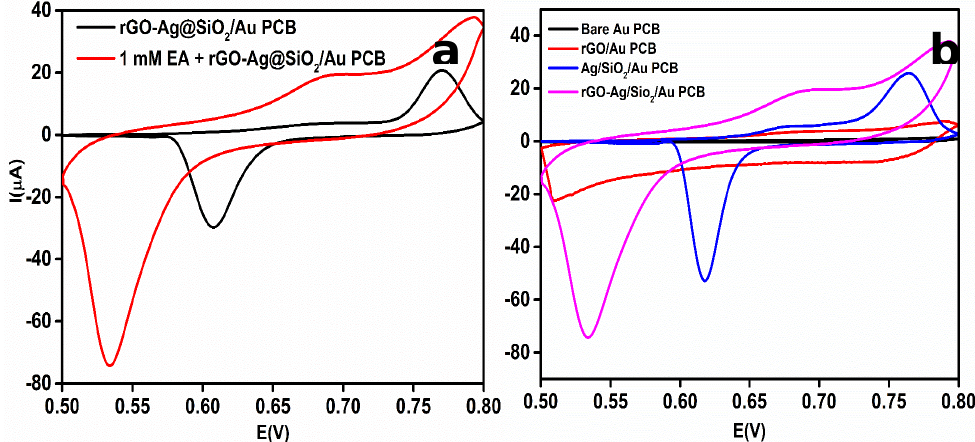
Figure 6. ( a ) Comparison of cyclic voltammetry (CV) response at rGO-Ag@SiO 2 / Au PCB in the absence and presence of 1 mM Etidronic acid (EA) in 0.1 M NaOH. ( b ) CV response of 1 mM EA at bare Au PCB, rGO / Au PCB, Ag@SiO 2 / Au PCB, and rGO-Ag@SiO 2 / Au PCB in 0.1 M NaOH.